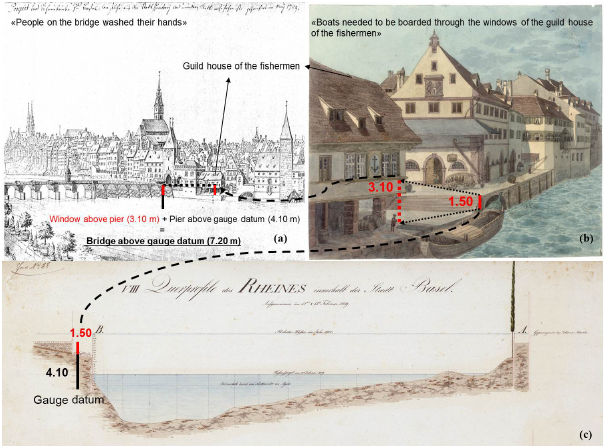
Figure 3. Reconstruction of peak water levels of the 1424 and 1480 River Rhine flood events in Basel based on narrative landmark ref- erences (references: levels of the bridge and the windows of the guild house) in combination with a cross profile taken in 1819, right on the spot of the referenced landmarks. (a) Blick auf das linke Rheinufer, 1759; artist: Emanuel Büchel, StABS, Collection Weber- Oeri, Topo 2. (b) Blick von der Rheinbrücke auf das Schiffleuten- Zunfthaus; artist unknown, StABS, I 537. Below: Querprofile des Rheines innerhalb der Stadt Basel. Made on 12 and 13 February 1819, StABS, Planarchiv A6,